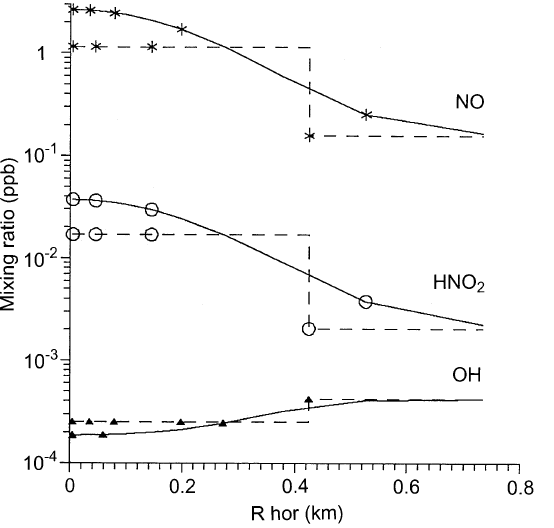
Fig. 1. NO, HNO (cid:50) and OH mixing ratio distributions along the plume axis horizontal cross radius in the box ( dashed lines ) and the 2-D Gaussian ( solid lines ) plume models for the basic variant in the flight corridor (FC) at 25 min after the midday injection